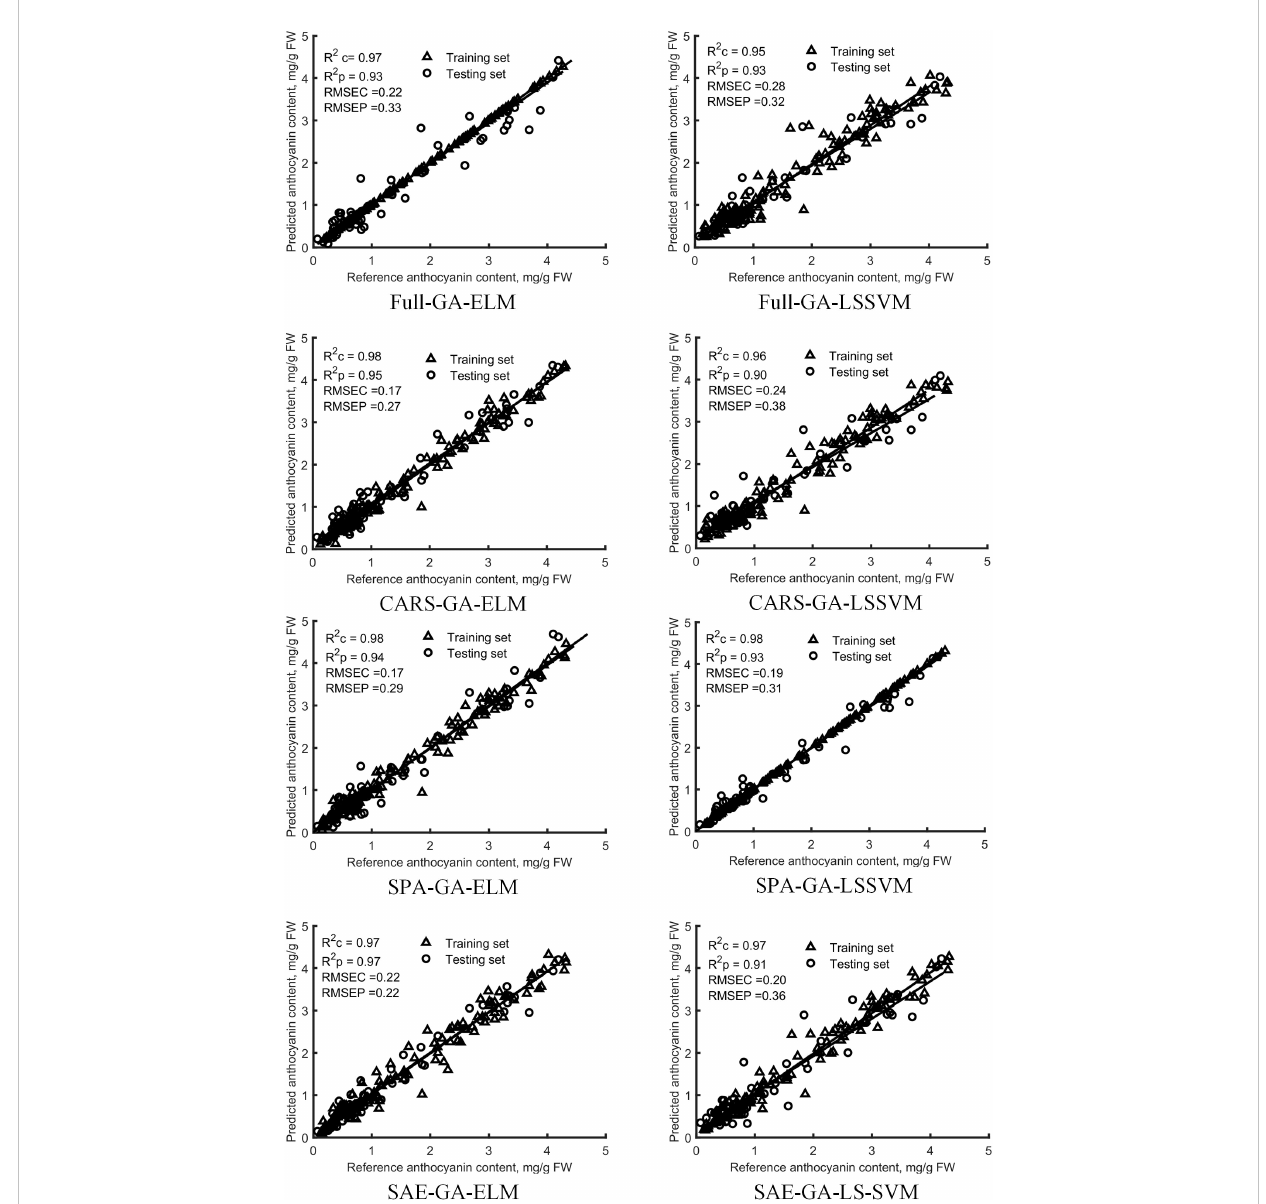
FIGURE 8 Diagnosis results of anthocyanin content in the training set and testing set by GA-ELM and GA-LS-SVM models based on all-band and feature